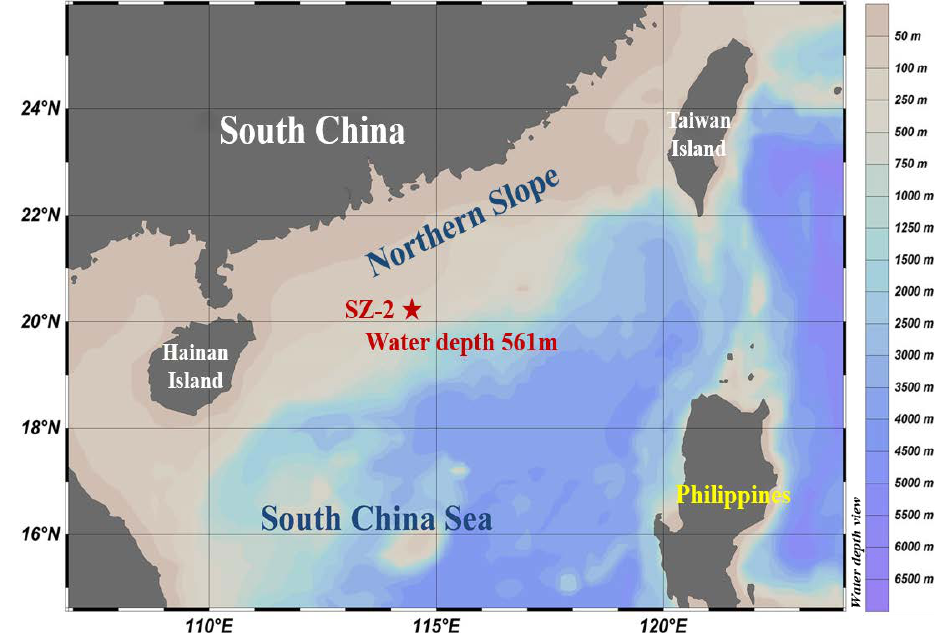
Figure 1. Sampling site (modified from